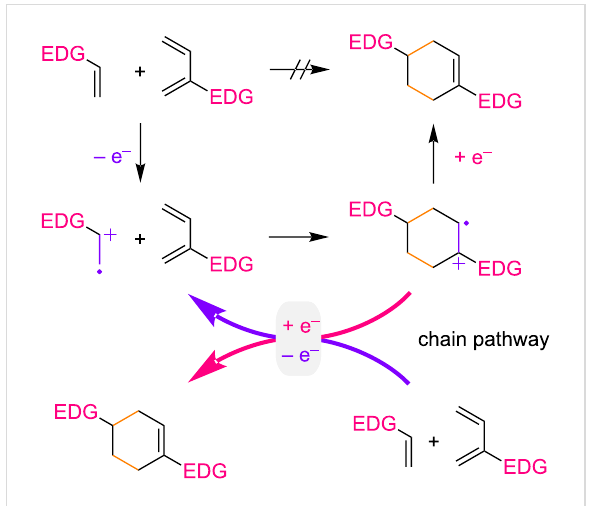
Figure 1: Plausible mechanism of the radical cation Diels–Alder reac- tion (EDG: electron-donating group).